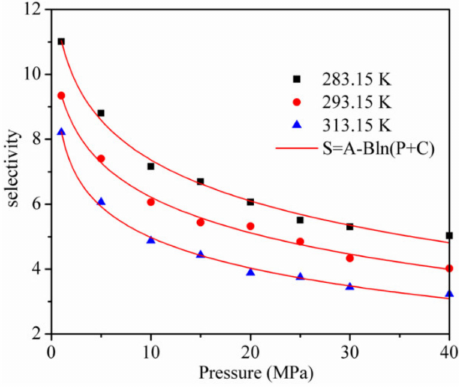
Figure 7. Selectivity of CO 2 / CH 4 in